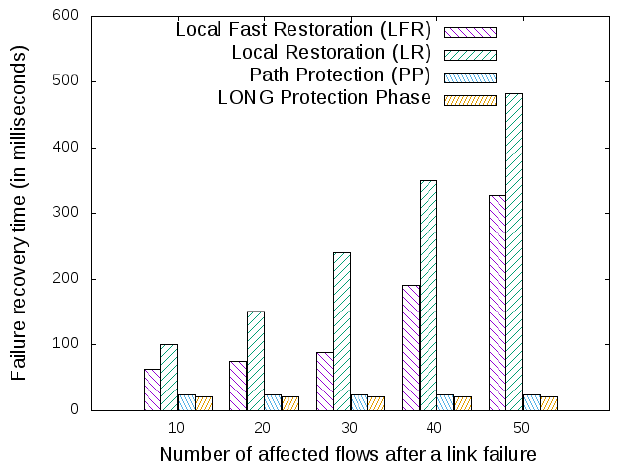
Figure 8. Results for failure recovery time after a link failure in the Abilene